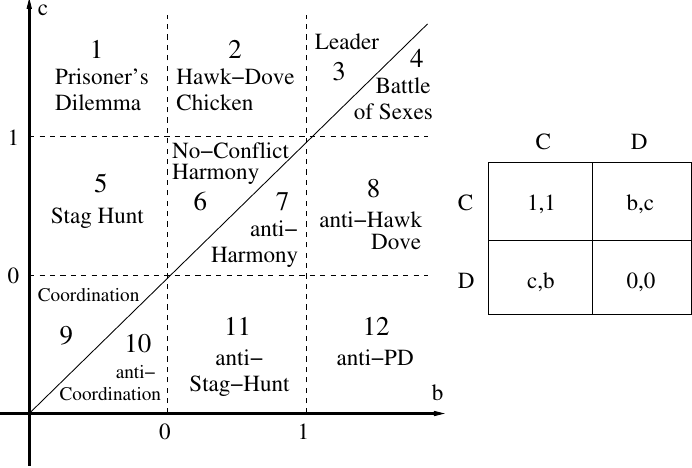
Figure 1. Symmetric ordinal 2 × 2 games with parameters b and c